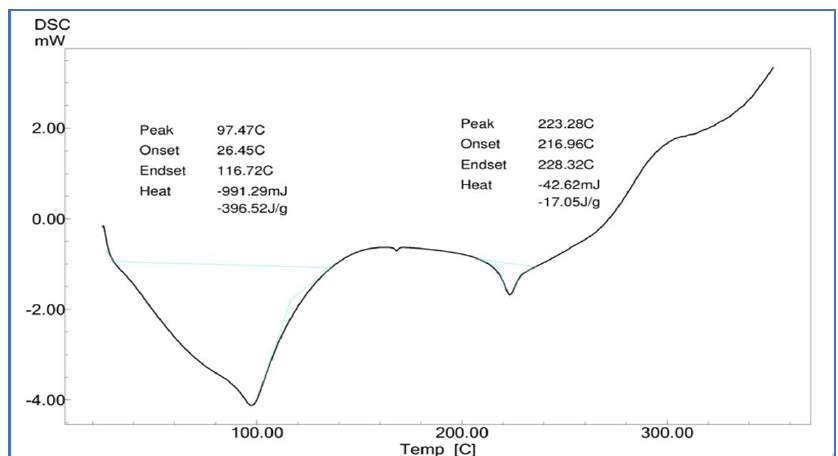
Figure 5. FTIR of Calendula officinalis oil-loaded gelatin sponge.